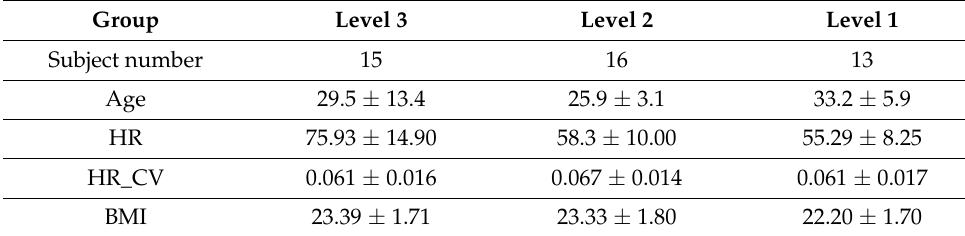
Table 1. Characteristics of the study